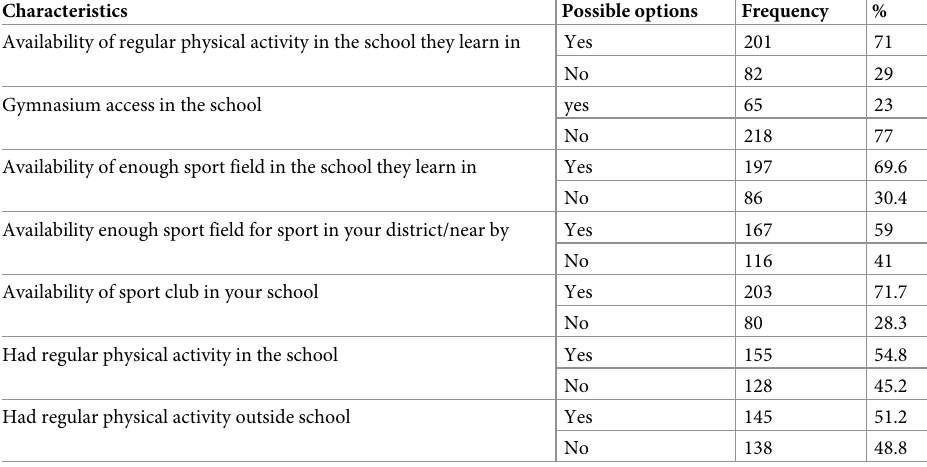
Table 4. Availability and accessibility of physical activity equipment for adolescents in, Addis Ababa city, Ethiopia.